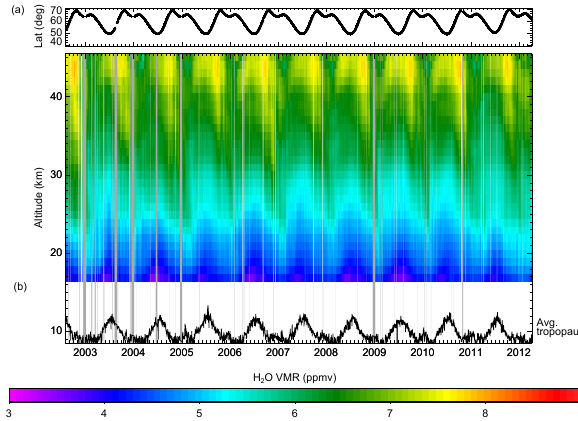
Figure 6. Time series of daily averaged SCIAMACHY H 2 O VMR profiles from August 2002 to April 2012. In the top graph the lat- itudes of observations as a function of time are shown. Grey verti- cal bars mask out times of reduced SCIAMACHY performance or missing data. The black curve at lower altitudes shows the average tropopause height.